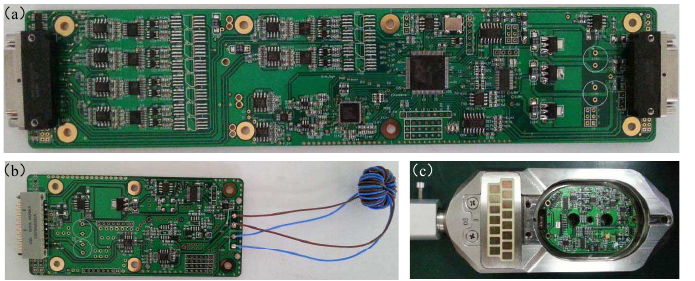
Figure 4. The pictures of ( a ) control-processing unit, ( b ) transmitter unit and ( c ) signal acquisition unit in